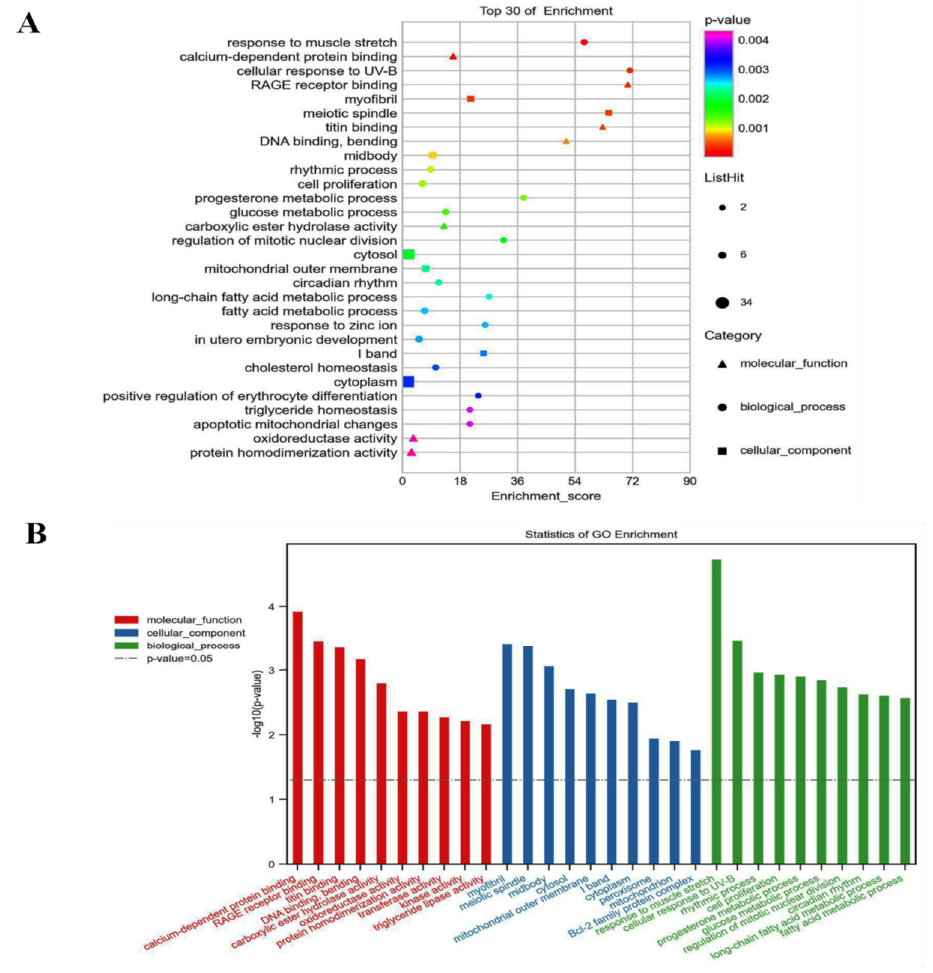
Figure 6. Gene GO analyzed the 72 different expression genes. ( A ) Gene GO analyzed the 72 different expression genes.Bubble chart; ( B ) gene ontology (GO) analysis result. GO analysis consists of biological process, cellular component, and molecular function. The vertical items are the names of gene ontology terms, and the length of horizontal graph represents the adjusted p -value. The depth of the color represents the − log(10)-adjusted p -value. These analyses using software of g: Profiler and Cytoscape 2.8.2 software.